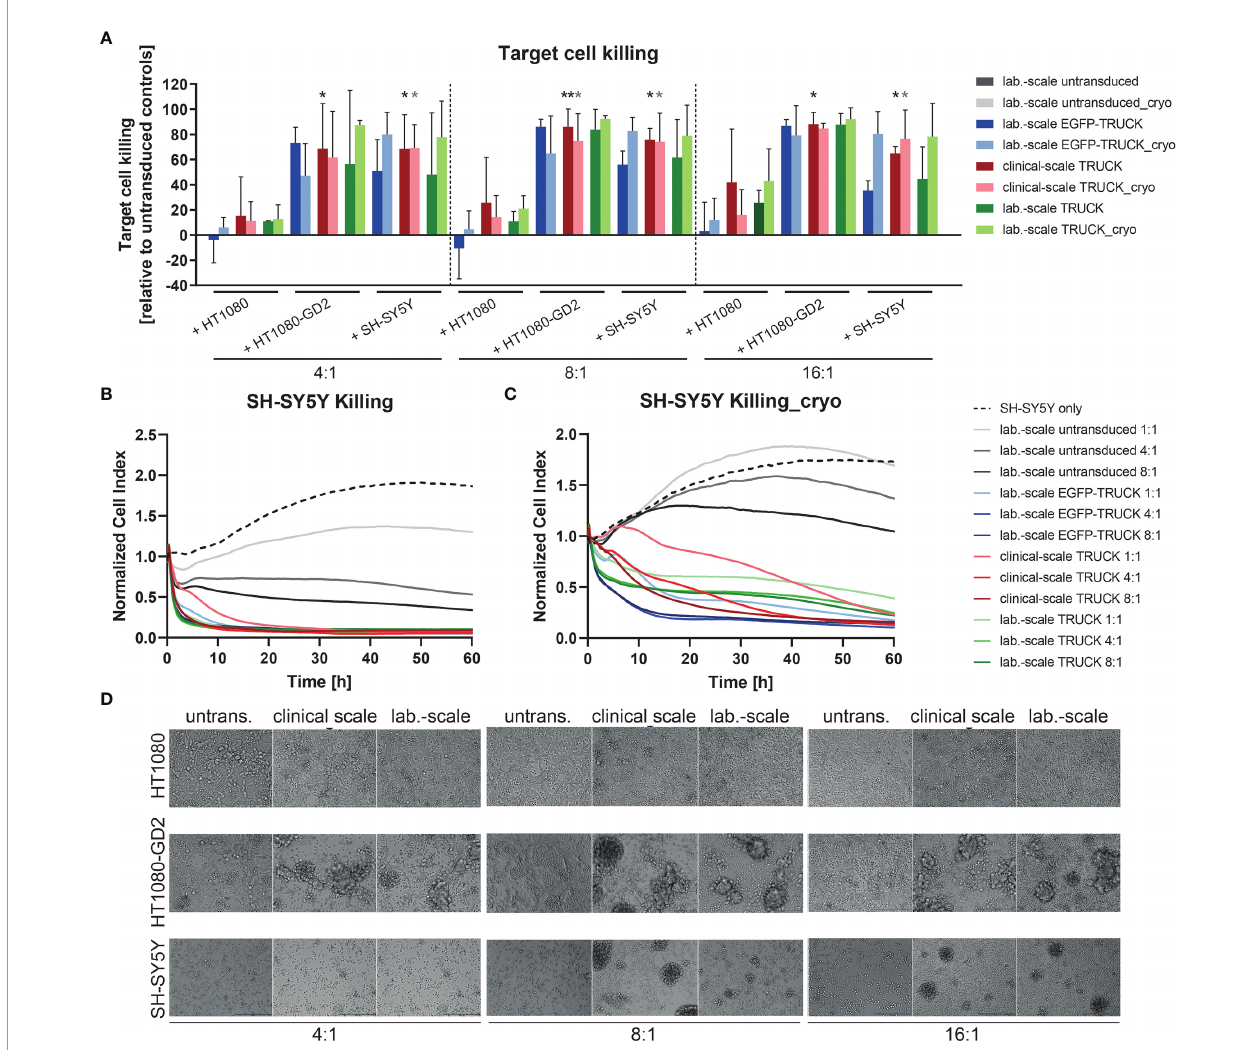
FIGURE 6 | Clinical-scale-manufactured IL-18 TRUCKs targeting GD 2 speci fi cally eliminate GD + 2 target cells. IL-18 TRUCKs targeting GD 2 were generated using the CliniMACS Prodigy ® (clinical-scale TRUCK; n=2) or under laboratory conditions (lab.-scale TRUCK; n=3). Untransduced T cells (lab.-scale untransduced; n=3) as well as GD 2 TRUCKs with inducible EGFP expression (EGFP-TRUCK; n=3) served as control. The manufactured cells were tested for cytotoxicity either directly after the generation process (d12) or after cryopreservation and thawing (cryo) by co-cultivation with the indicated target cells and in the indicated effector-to-target (E:T) ratios. (A) Target cell killing after 48h was measured by fl ow cytometry as percentage of killed CD3 - cells relative to those eliminated in co-cultures with untransduced T cells. Data is shown as mean ± SD. Statistical differences of large-scale TRUCKs co-cultured with different target cells directly after generation or cryopreservation as well as in comparison to all laboratory-scale manufactured cells were assessed by Kruskal-Wallis and Dunn ’ s test, whereby only signi fi cant differences are shown (*p ≤ 0.05, **p ≤ 0.01). (B, C) Killing of SH-SY5Y cells by the generated cells (B) directly after their generation (here: lab.-scale untransduced n=2, clinical-scale TRUCK n=1) or (C) after cryopreservation and thawing was determined with the XCelligence Real-Time Cell Analyzer. Cell indices were normalized to the respective indices after T cell addition. Data is shown as mean. (D) Representative transmitted-light microscope images of co-cultures of fresh effector cells with target cells taken after 48 h by an Olympus IX81 microscope combined with a digital B/W camera using 10x objective